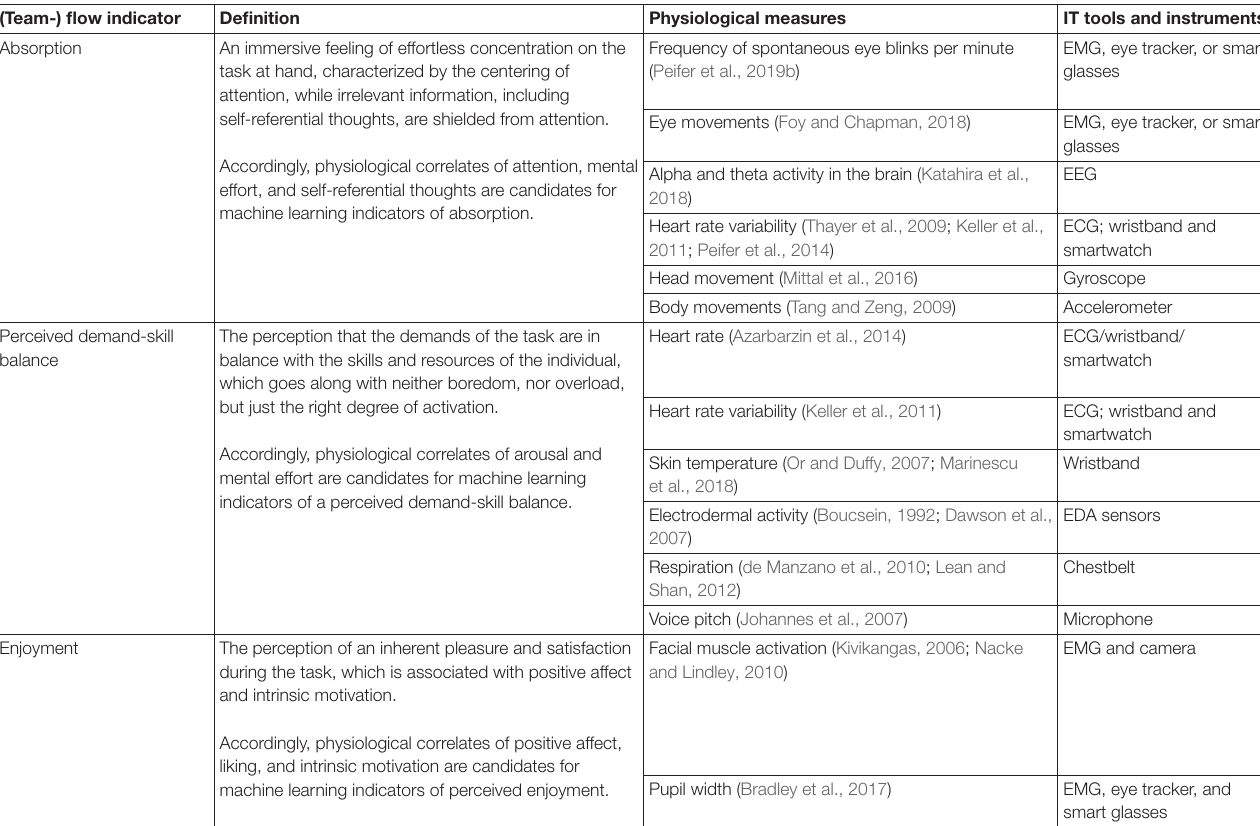
TABLE 4 | Physiological measures of flow experience applicable for machine learning as part of a team flow algorithm (compare Peifer and Engeser, 2021; Peifer and Tan, 2021). (Team-) flow indicator Definition Physiological measures IT tools and instruments